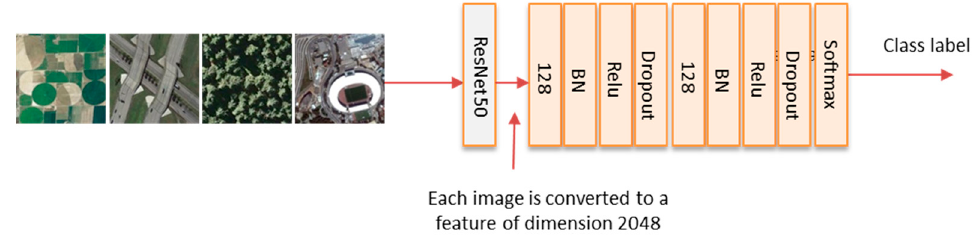
Figure 3. One branch of MB-Net related to the k -th source domain.